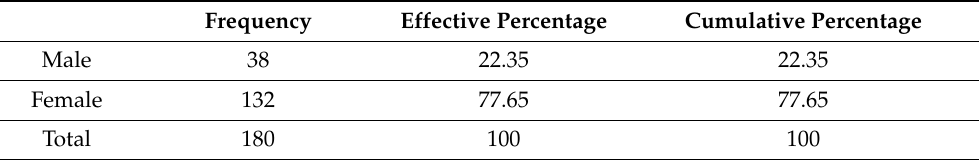
Table 1. User gender statistics.